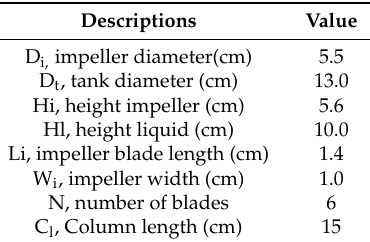
Table 1. Descriptions of Rushton turbine (RT) impeller and 2 L stirred-tank bioreactor.